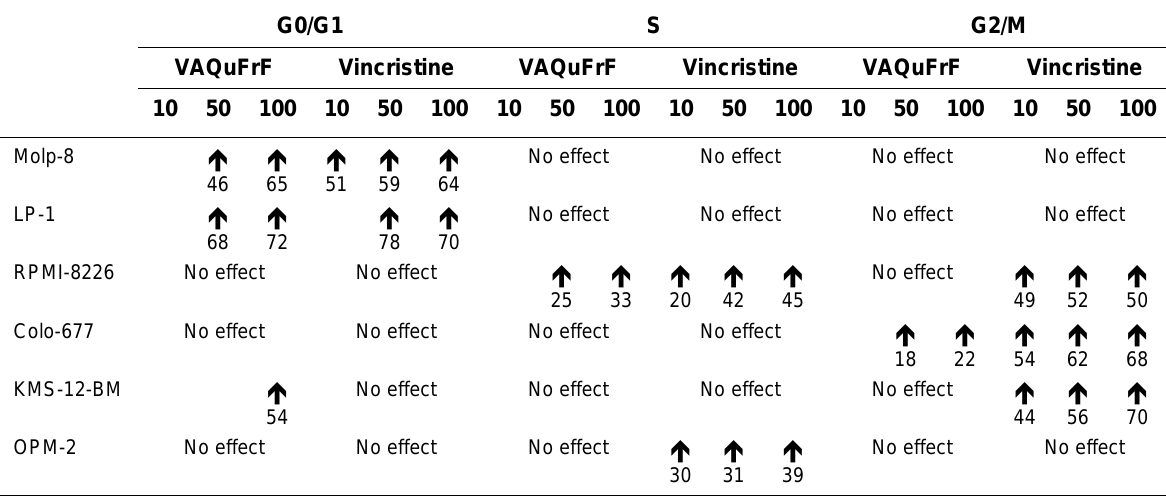
Accumulation of Human Multiple Myeloma Cells in Different Cell Cycle Phases